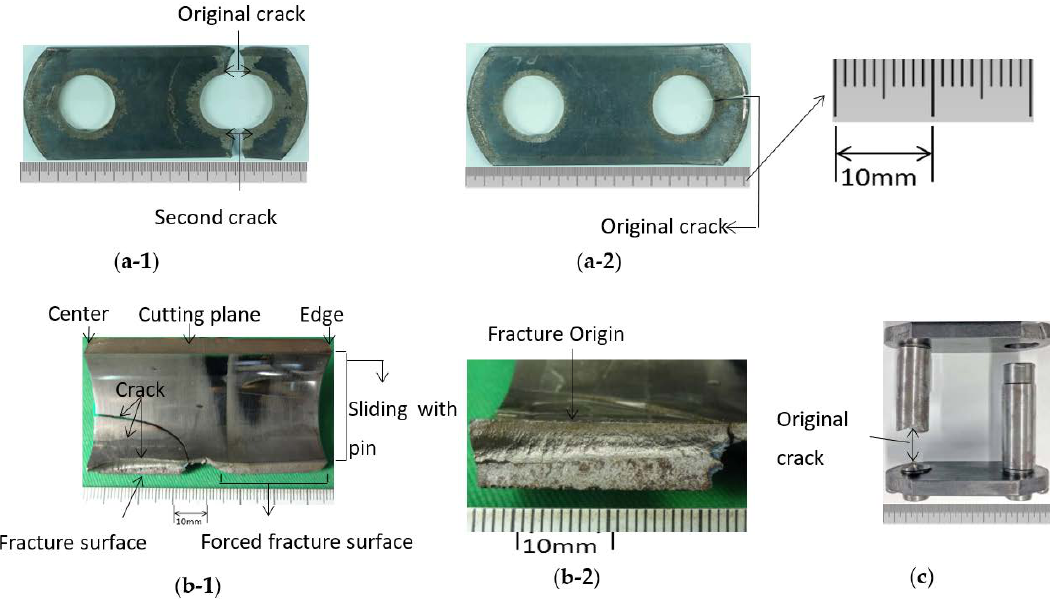
Figure 4. Examples of the broken parts of the roller chain: ( a-1 ) broken inner plate perpendicular to tensile, ( a-2 ) broken inner plate at tensile direction; ( b-1 ) broken bush, ( b-2 ) broken bush; ( c ) broken pin at step corner.